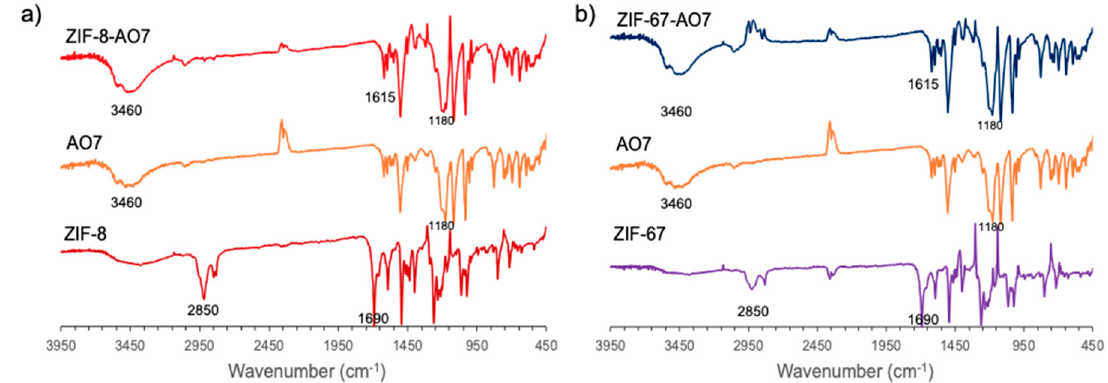
Figure 3. IR spectra of the ( a ) ZIF-8 and ( b ) ZIF-67 before and after dye adsorption.